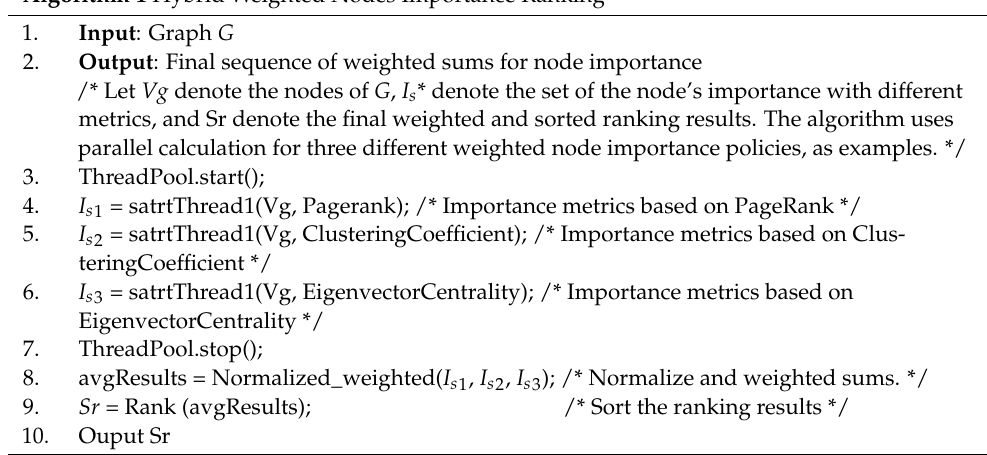
Algorithm 1 Hybrid Weighted Nodes Importance